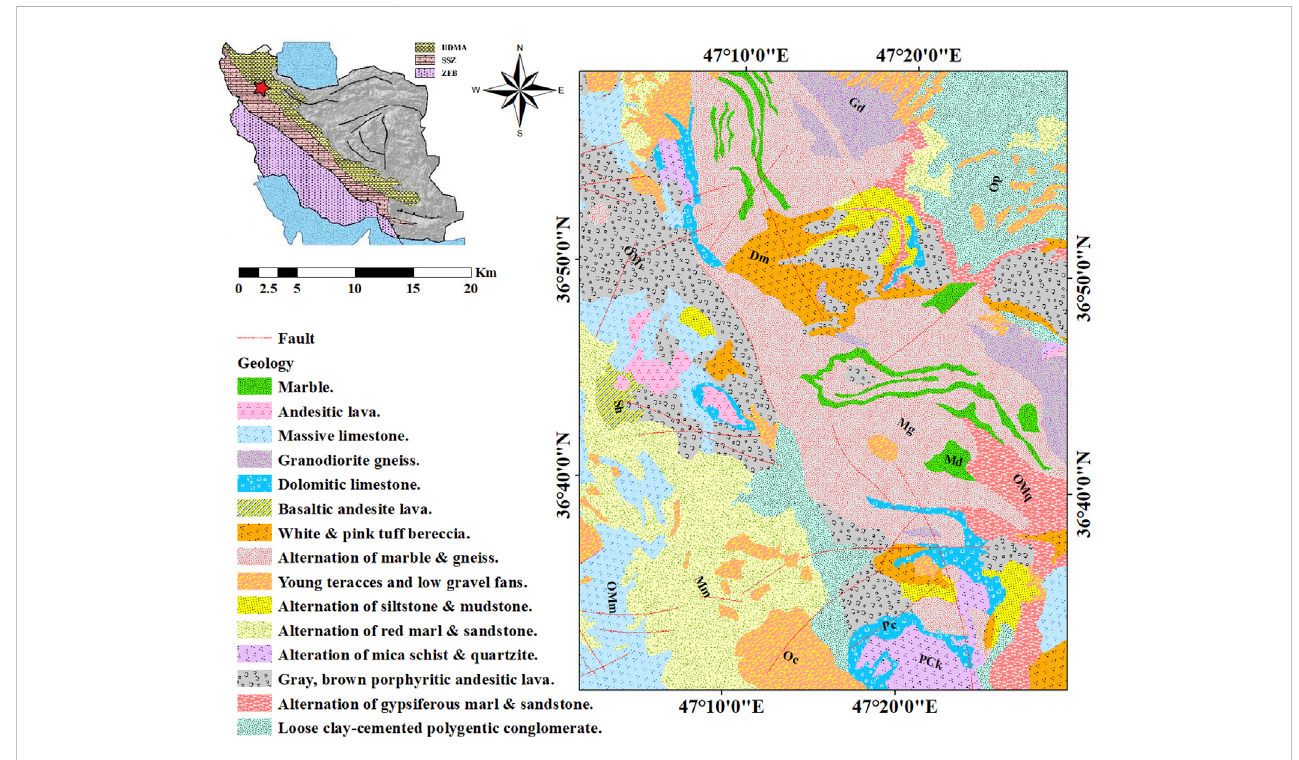
FIGURE 1 Simpli fi ed geological map (1:100,000) of the region of interest (Takht-e